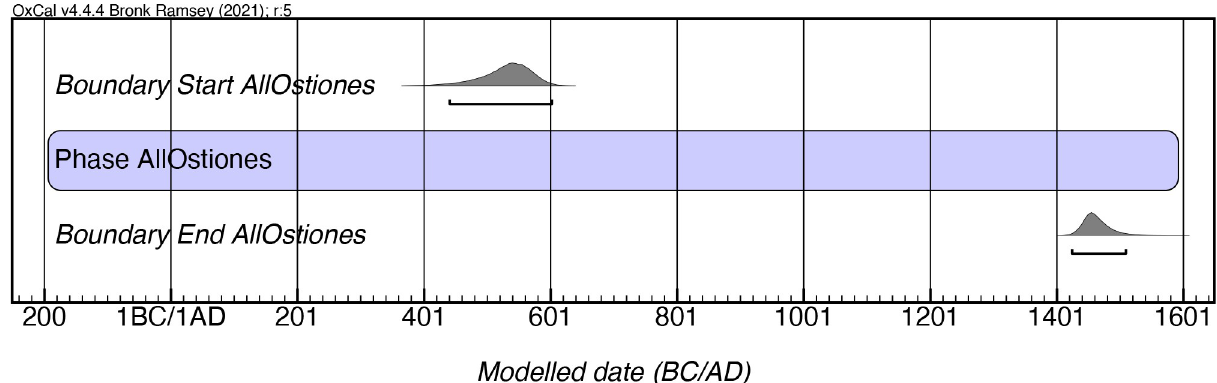
Fig 10. Modeled date ranges for the Ostiones style in Puerto Rico. Probability distributions indicate modeled 2 σ (95.4%) confidence intervals for beginning and end of phase.